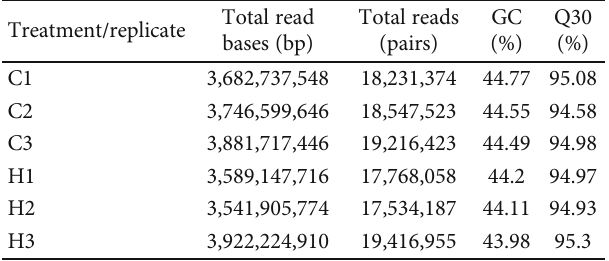
Table 1: Raw data statistics and quality assessment.